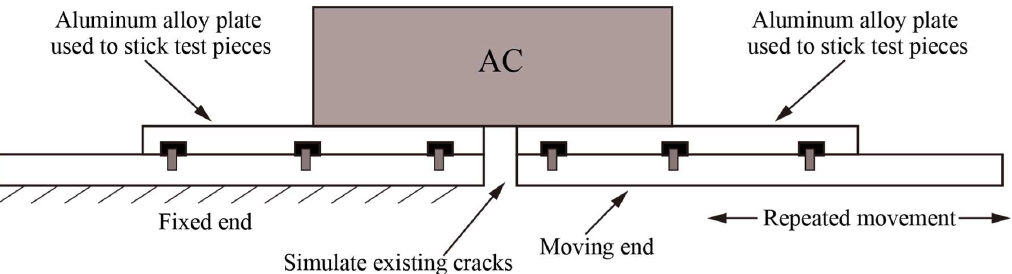
Figure 5. Schematic diagram of the OT model.